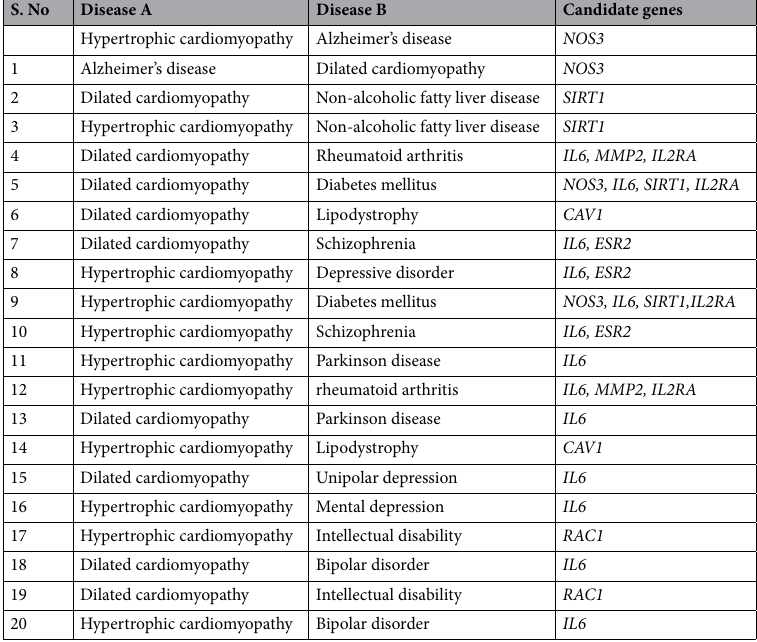
Table 1. A representative disease-disease association of predicted candidate genes that are screened based on mouse phenotype